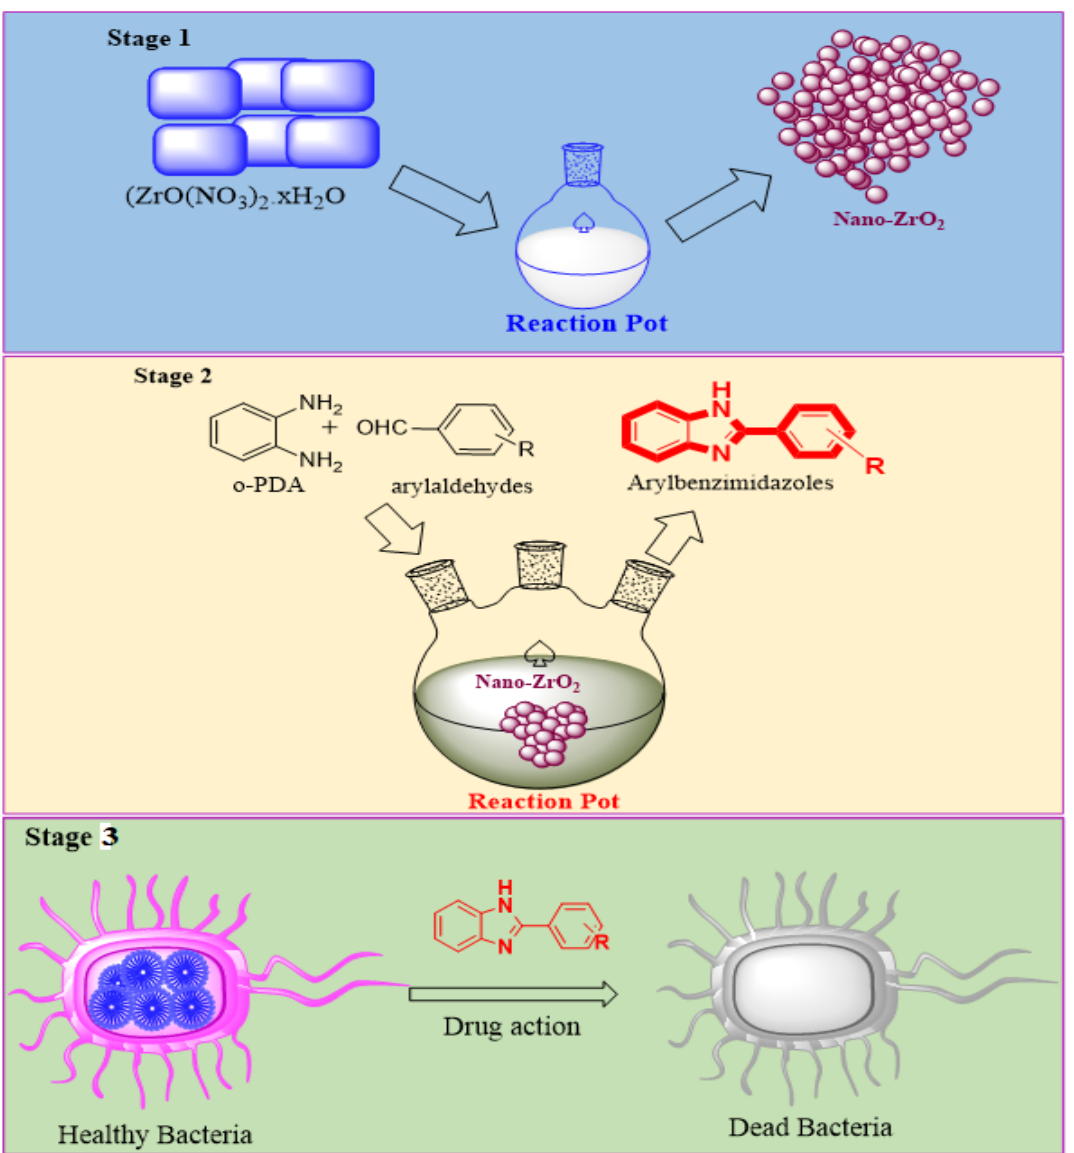
Figure 1. Synthesis of nano-ZrO 2 catalyst (Stage 1) and aryl benzimidazoles ( 3 , Stage 2) and antibacterial and antifungal activities (Stage 3).